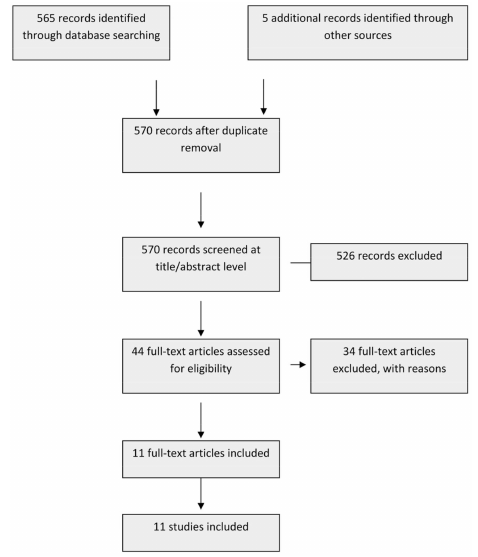
Figure 1. Flowchart of the screening